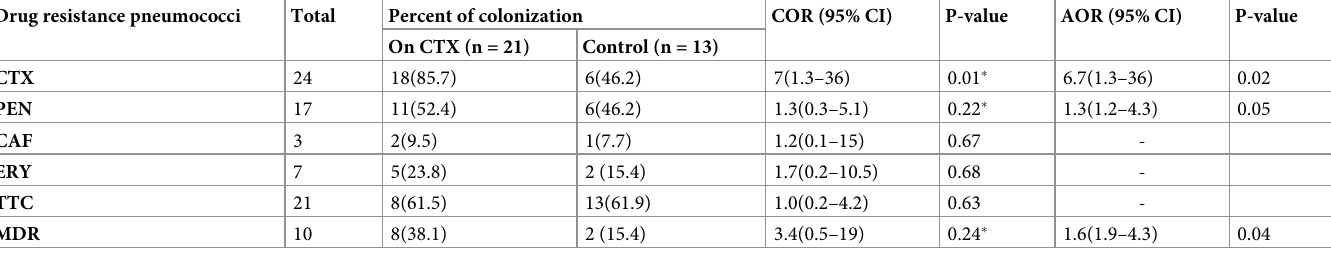
Table 3. Risk of colonization with drug-resistant pneumococci among study participants by their CTX prophylaxis status: A multivariate logistic regression analy- sis, Arba Minch, 2018 (n = 34). Drug resistance pneumococci